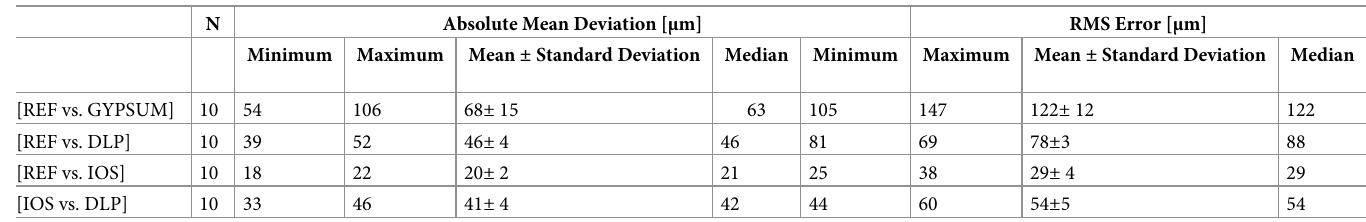
Table 1. Trueness